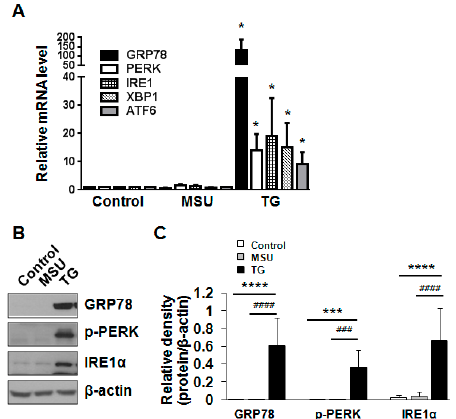
Figure 3. MSU crystal-induced chondrocyte death was not related to ER stress. ( A ) The effect of MSU crystals on the mRNA level of the ER stress markers. Human chondrocytes were incubated with thapsigargin (TG, 0.5 µM) or MSU (200 µg/mL) for 24 h. The mRNA levels of GRP78, PERK, IRE1, XBP1, and ATF6 were measured by RT-qPCR. Data represent the mean ± SD for duplicate experiments from three different donors ( n = 3). * p < 0.05 vs. untreated cells; ( B ) The effect of MSU crystals on the protein expression of the ER stress markers. Human chondrocytes were incubated with TG (0.5 µ M) or MSU crystals (200 µ g/mL) for 24 h. The protein expression of GRP78/Bip, p-PERK, and IRE1 α was determined by Western blot analysis. β -actin was used as a loading control. Data are representative of three independent experiments from three different donors ( n = 3); ( C ) The relative expression level of GRP78/Bip, p-PERK, and IRE1 α proteins. Protein density was normalized to β -actin. The bars represent the mean ˘ SD of triplicate samples from three different donors. *** p < 0.005, **** p < 0.001 vs. untreated control. ### p < 0.005, #### p < 0.001 vs. MSU crystal-treated